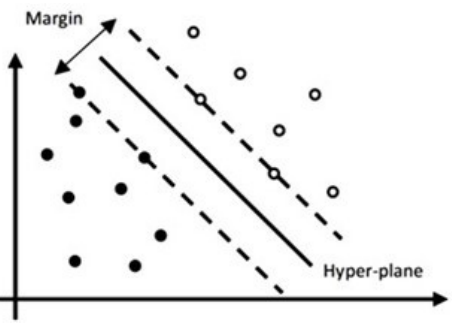
Figure 2. The margin between hyperplane and